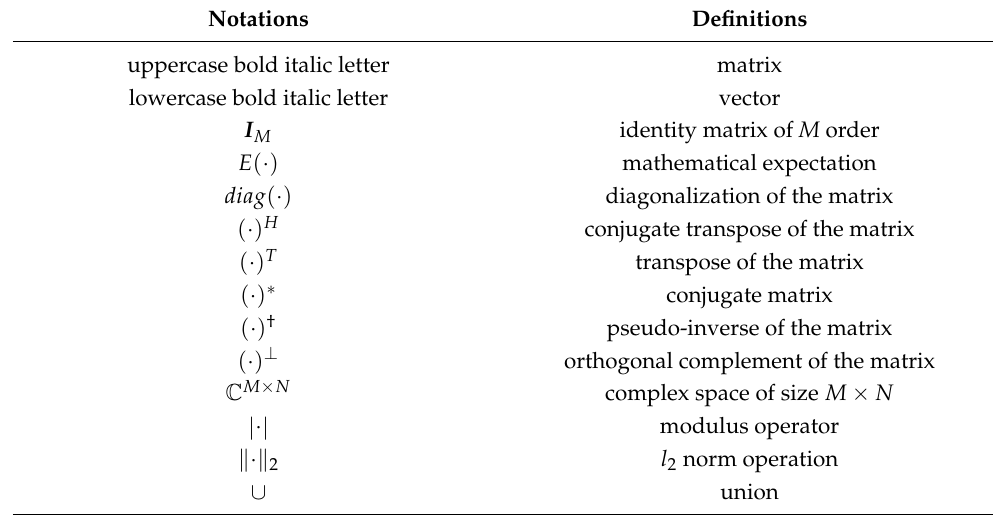
Table 1. Related